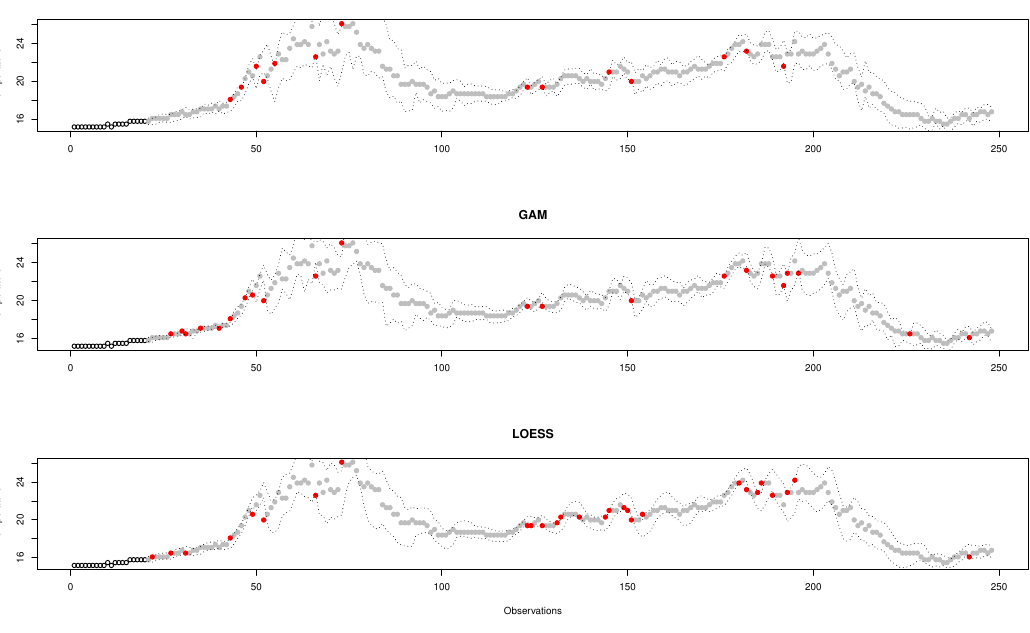
Figure 9. Example of classification made by the three proposed binary